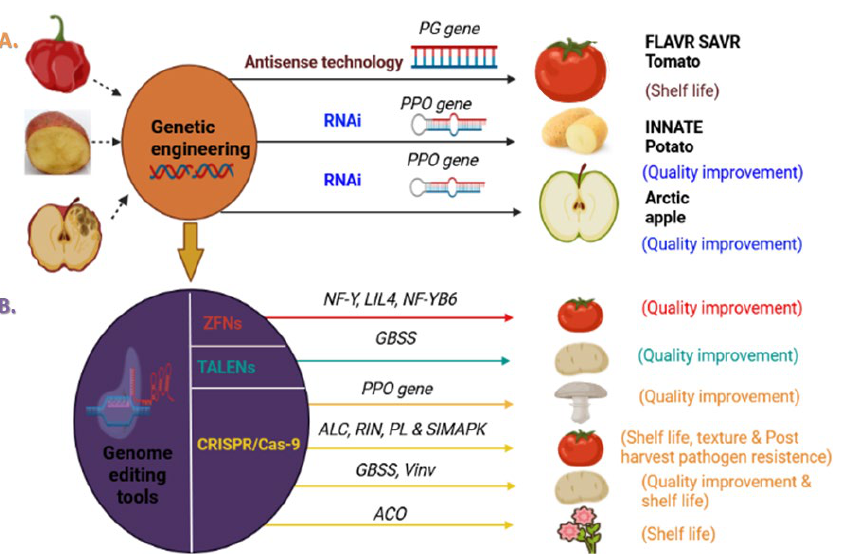
Figure 1. Biotechnological approaches improved post-harvest shelf life and quality of many horticultural crops: ( A ) anti-sense RNA (asRNA) and RNA interference (RNAi) technologies were used to enhance shelf life and quality in tomato, potato, and apple by targeting different genes, PG (polygalacturonase) and PPO (polyphenoloxidase), which showed various limitations such as off-target effect and concerned safety assessments. The arrow from ( A ) to ( B ) depicts the transition from biotechnological tools, i.e., genetic engineering to modern genome editing tools. ( B ) In contrast, advanced biotechnological approach, i.e., genome editing tools such as ZFNs, TALENs, and CRISPR/Cas-9 successfully modified the important post-harvest traits such as shelf life, texture, quality improvement, and post-harvest pathogen resistance.